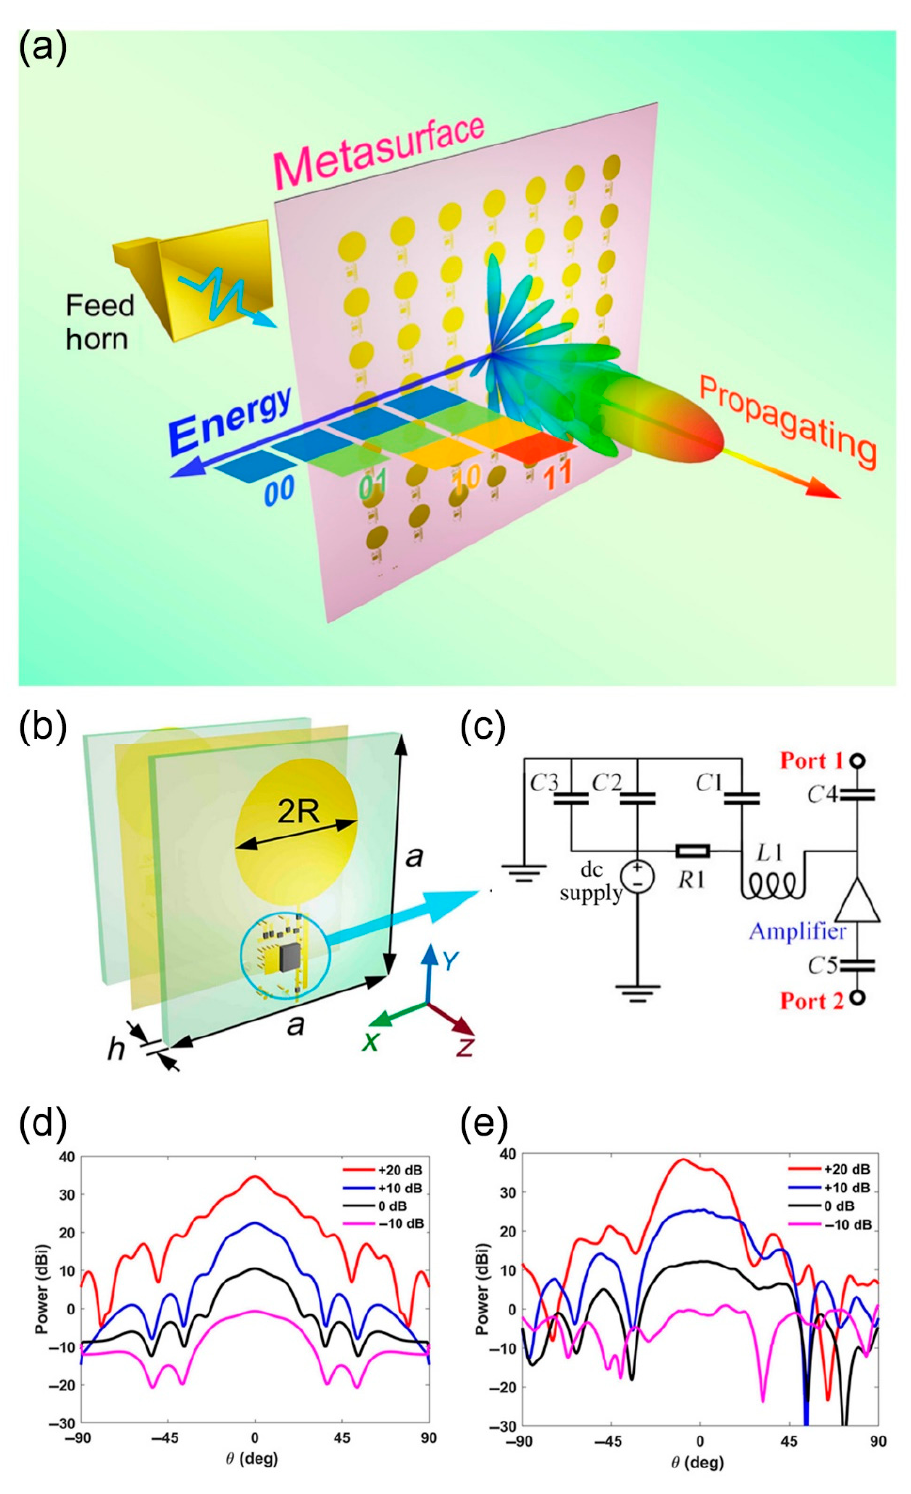
Figure 9. ( a ) Schematic of a spatial-energy digital-coding metasurface based on active amplifiers (from Figure 1 of Ref. [97]). ( b ) The detailed structure of the metasurface element (from Figure 2a of Ref. [97]). ( c ) The detailed circuit connections of its circuit components (from Figure 2b of Ref. [97]). ( d , e )The simulated and measured far-field results of coding states “00”, “01”, “10”, and “11”(from Figure 7a,b of Ref. [97]). Reproduced with permission from Ref. [97] provided by the American Physical Society and SciPris. License number: RNP/21/JUL/041860.